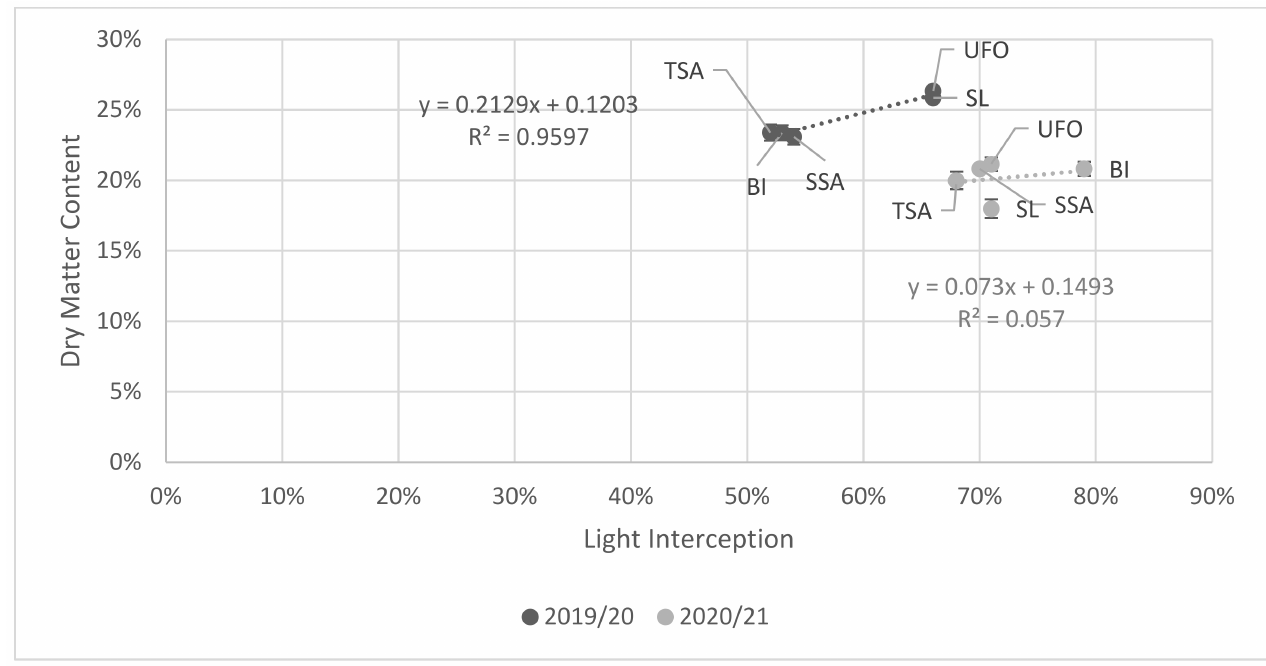
Figure 3. The correlation between DMC of sweet cherry cultivar ‘Kordia’ and light interception across different training systems and seasons. Error bars represent one standard error for each training system and n = 6 for each system in a season.